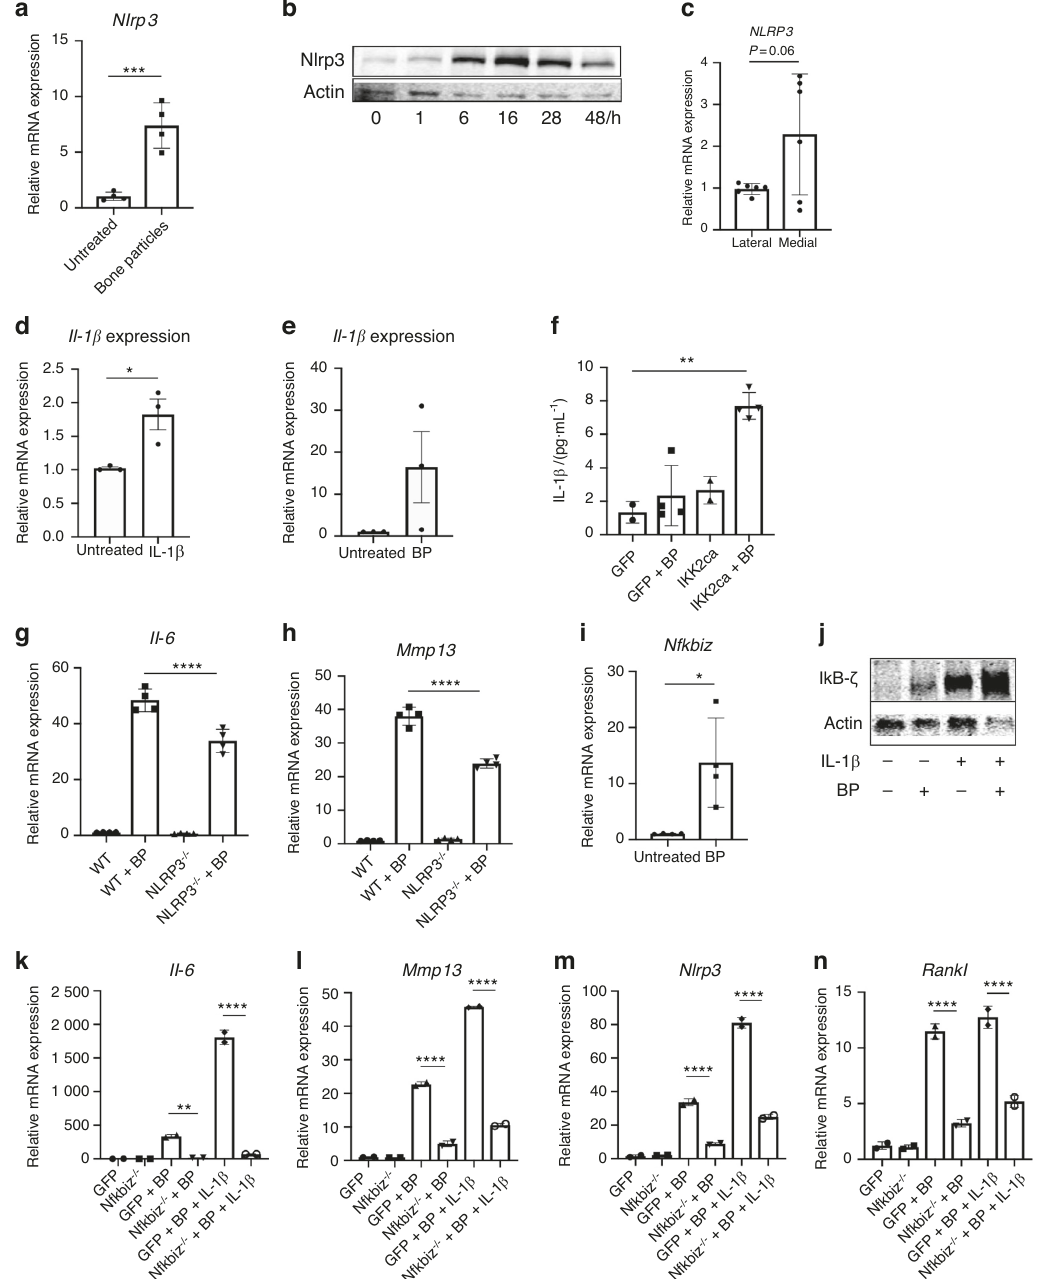
Fig. 4 Bone particles promote in fl ammation via NLRP3 and I κ B- ζ activity. a Primary chondrocytes were cultured with BP for 24 h and Nlrp3 gene expression was measured (*** P = 0.000 9). Bars represent mean ± SEM from n = 4 independent experiments. b Immunoblotting was performed for Nlrp3 protein using chondrocytes lysates under BP treatment time course, with actin loading used as control. The representative image is shown. c Medial and lateral knee articular cartilage was isolated from patients undergoing TKA with medial compartment OA. Gene expression analysis was performed for NLRP3 . Bars represent mean ± S.D. for n = 6 samples. d , e Cells were treated with IL-1 β or BP for 24 h and IL-1 β gene expression was measured. Bars are mean ± SD from three separate experiments. (* P = 0.024 8). f Cells were retrovirally transduced with GFP or IKK2ca, then treated with bone particles for 24 h. Supernatant was collected and ELISA was performed for IL-1 β levels (GFP vs IKK2ca + BP ** P = 0.001 8, n = 4 replicates). g , h Chondrocytes isolated from WT or Nlrp3-de fi cient mice and treated with BP for 24 h. Il-6 and Mmp13 gene expression measured by qPCR ( IL-6 : WT + BP vs Nlrp3 − / − + BP **** P < 0.000 1, Mmp 13: WT + BP vs Nlrp3 − / − + BP **** P < 0.000 1). Bars are mean ± SD for n = 4 replicates. i Primary chondrocytes were treated with BP for 24 h. Nfkbiz gene expression was measured by qPCR (* P = 0.018 7). Bars are mean ± SEM for n = 4 independent experiments. j Chondrocytes were exposed to IL-1 β and/or bone particles. Lysates were collected and Immunoblotting was performed for I κ B- ζ . Representative immunoblot is shown. k – n Nfkbiz fl ox chondrocytes were transduced with adeno- GFP (WT) or adeno-cre ( Nfkbiz − / − ). Cells were then treated with BP ± IL-1 β . Gene expression of Il-6 , Mmp13 , Nlrp3 and Rankl was measured by qPCR ( IL-6 : GFP + BP vs Nfkbiz − / − + BP ** P = 0.002 9, GFP + BP + IL-1 β vs Nfkbiz − / − + BP + IL-1 β **** P < 0.000 1. Mmp13 : GFP + BP vs Nfkbiz − / − + BP **** P < 0.000 1, GFP + BP + IL-1 β vs Nfkbiz − / − + BP + IL-1 β **** P < 0.000 1. Nlrp3 : GFP + BP vs Nfkbiz − / − + BP **** P < 0.000 1, GFP + BP + IL-1 β vs Nfkbiz − / − + BP + IL-1 β **** P < 0.000 1. Rankl : GFP + BP vs Nfkbiz − / − + BP **** P < 0.000 1, GFP + BP + IL-1 β vs Nfkbiz − / − + BP + IL-1 β **** P < 0.000 1). Bars represent mean ± S.D. from one representative experiment out of